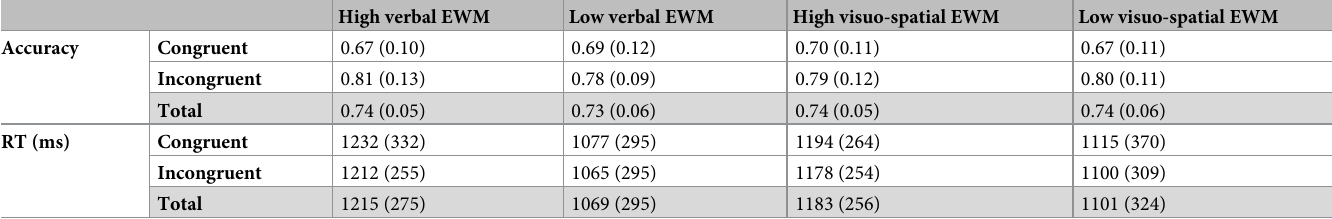
Table 2. Numerosity Comparison performance (accuracy, RT) of each group in congruent vs. incongruent